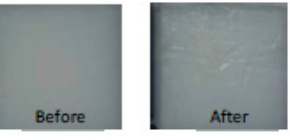
Figure 16. Before and after on propellant cube.